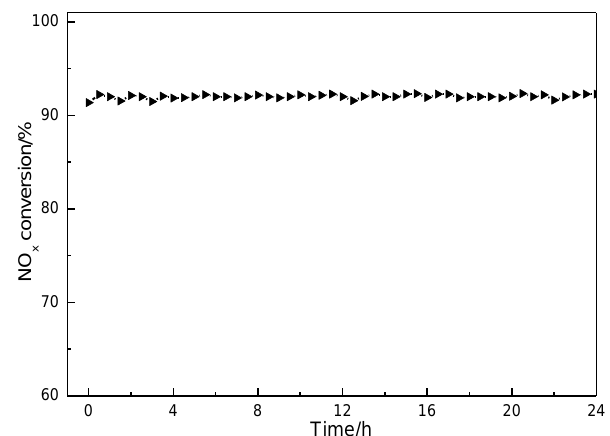
Figure 9. Effect of temperature on SCR activity on SOC and SSOC. 300 ppm NO, 15% O 2 , Ar as balance gas, NH 3 /NO ratio: 1.0, GHSV: 5000 h – 1 .